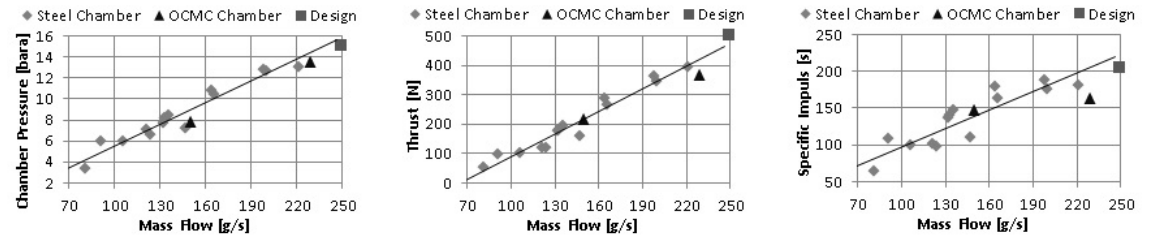
Figure 30. Summary of the test data of the steel and OCMC chambers.